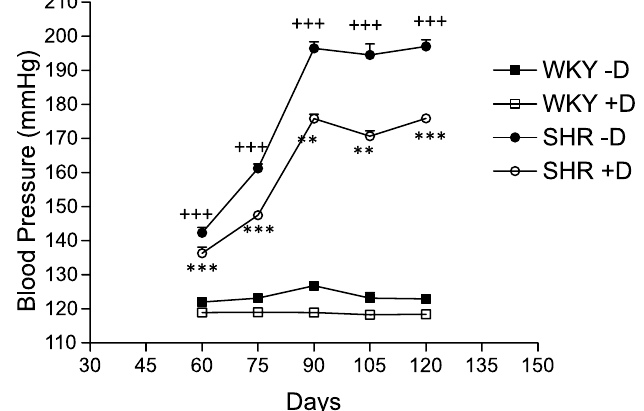
FIGURE 1 - Effect of D- a -tocopherol on blood pressure in SHR and control rats. Error bars indicate SEM. *** p < 0.001 compared to SHR without D- a -Tocopherol and +++ p < 0.001 compared to WKY without D- a -Tocopherol. (ANOVA followed by the Bonferroni test). Squares = WKY, circles = SHR, open symbols = without D- a -tocopherol, closed symbols = with D- a -tocopherol. TABLE I - Effect of D- a -Tocopherol (D) on renal function in SHR and control rats normotensive (WKY)